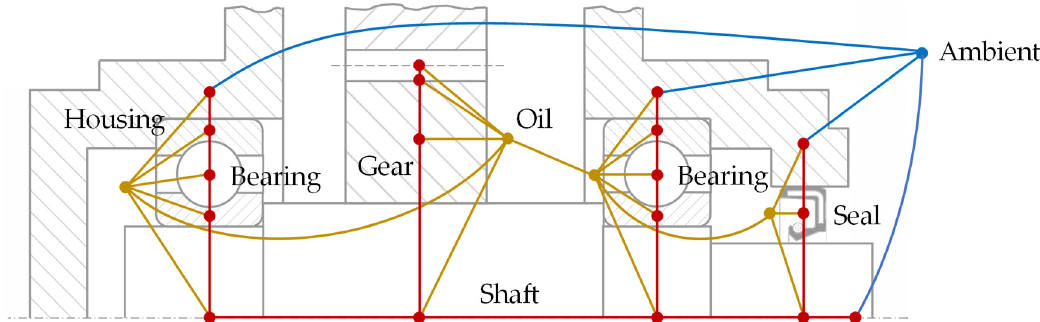
Figure 6. Exemplary representation of the thermal node model for a gearbox section.